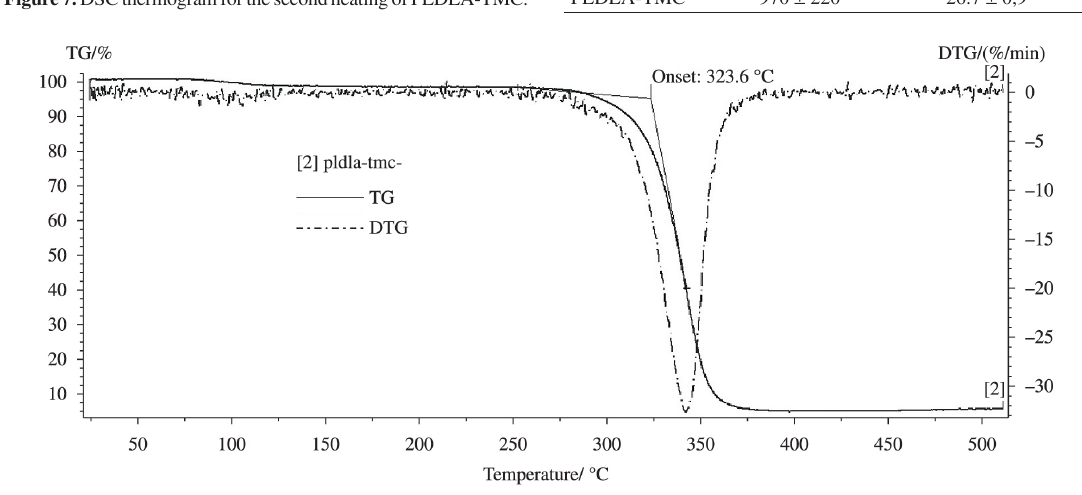
Figure 8. TGA of PLDLA-TMC.